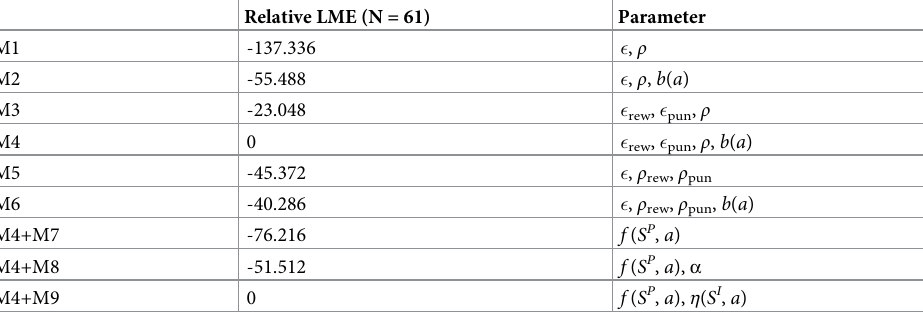
Table 2. Parameters contained in the models and Bayesian model comparison. Relative LME (N = 61) Parameter M1 -137.336 � , ρ M2 -55.488 � , ρ , b ( a ) M3 -23.048 � rew , � pun , ρ M4 0 � rew , � pun , ρ , b ( a ) M5 -45.372 � , ρ rew , ρ pun M6 -40.286 � , ρ rew , ρ pun , b ( a ) M4+M7 -76.216 f ( S P , a ) M4+M8 -51.512 f ( S P , a ), α M4+M9 0 f ( S P , a ), η ( S I , a ) Model 1, Model 3, and Model 5 assumed no bias for collect actions; in these models, we always set to zero, b ( a ) = 0, t whereas Model 2, Model 4, and Model 6 allow for bias to be estimated. Models 1–6 were fitted on data in the instrumental task; remaining models were fitted to the PIT task. Each column includes the relative log-model evidence for the model. Higher values (closer to zero) indicate more evidence for the model. The parameters column indicates which parameters were included in the model. � , � rew , and � pun : single learning rate, learning rate for reward, and learning rate for punishment, respectively. ρ , ρ rew , and ρ pun : single sensitivity, sensitivity for reward, and sensitivity for punishment, respectively. b ( a ): response bias. f ( S P , a ): Pavlovian factors. α : decay rate for transfer. η ( S I , a ): noise for transfer. Model 5 and Model 6 assumed identical learning rates but separate sensitivities for positive and negative feedback: ( r ; r < 0 pun t r ¼ ð 5 Þ r ; r > 0 rew t